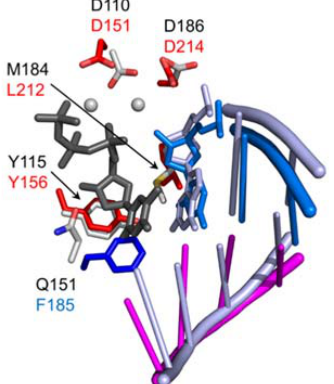
Figure 4. Alignment of the DNA polymerase active sites of Ty3 (PDB ID 4OL8, REF) and HIV ‐ 1 RT (PDB ID:1RTD). Carbon atoms of select Ty3 RT residues are shown in red (palm) and blue (fingers), and those of HIV ‐ 1 residues are in grey. The two catalytic metal ions and incoming dTTP are shown in grey and dark grey, respectively. Both HIV ‐ 1 DNA strands are shown as a light blue ladder, and the RNA template and DNA primer bound by Ty3 RT are shown in magenta and marine, respectively. The 3 ′‐ terminal nucleotides in both DNA primer strands are shown in stick form, and the stick radius of the incoming dTTP has been slightly expanded for contrast. Adapted from [37].